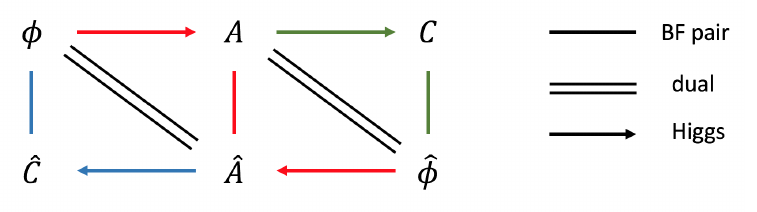
Figure 1: The relation between the two U ( 1 ) gauge theories A , ˆ A of [ 4 ] , the two non- gauge theories φ , ˆ φ of [ 4 ] , and the two U ( 1 ) gauge theories C , ˆ C . The solid lines mean that there is a (cid:90) gauge theory whose BF Lagrangian uses these two fields. N The double lines mean that the two theories are dual to each other. The arrows, for example, φ → A , mean that the former is the Higgs field of the latter. Each solid line and arrow gives a gapped (cid:90) theory, with certain equivalences. We use the same N color for the same (cid:90) gauge theory. In total, there are three different (cid:90) N A or ˆ A -theory in [ 5 ] : ( φ → A ) = ( ˆ φ → ˆ A ) = ( A − ˆ A ) , (cid:90) theories. (cid:90) N ˆ C -theory of Section 8: ( ˆ A → ˆ C ) = ( φ − ˆ C ) Section 6: ( A → C ) = ( ˆ φ − C ) , (cid:90) N